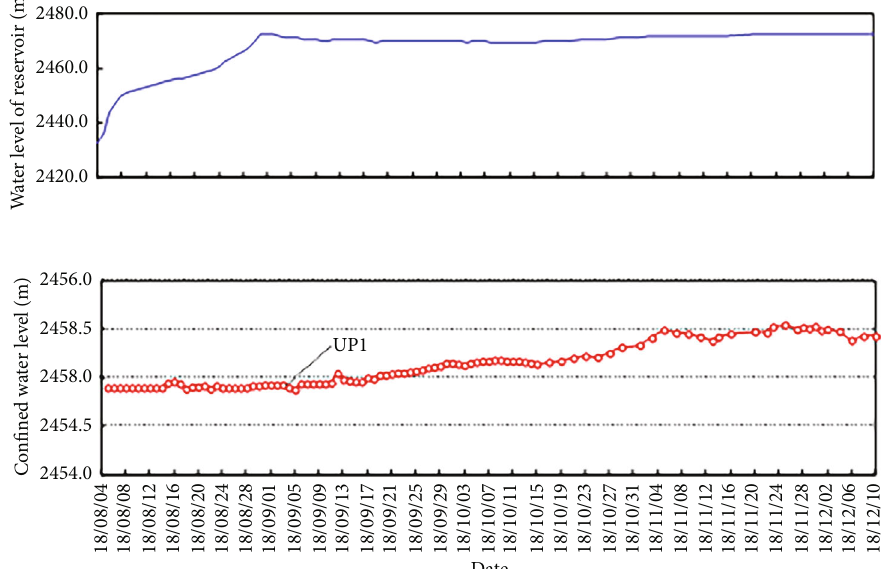
Figure 6: The monitoring reservoir water level and water level of seepage pressure at monitoring point UP1 at the cross section 0 +110 in the dam body.